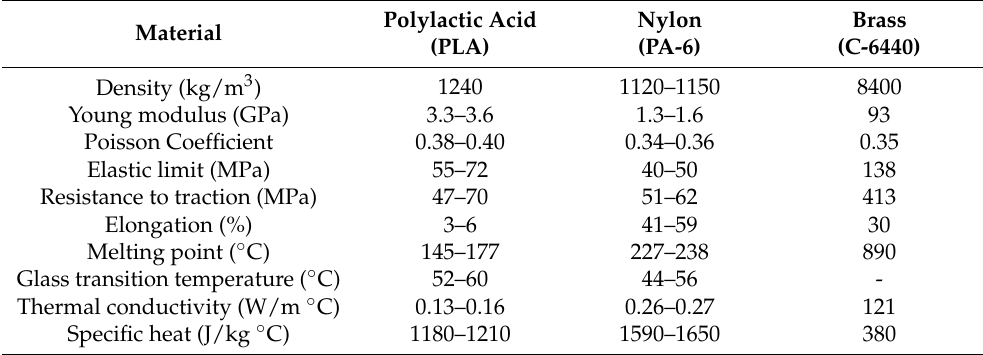
Table 2. Structural, mechanical, and thermal properties of the selected materials. Values obtained from Granta EduPack.